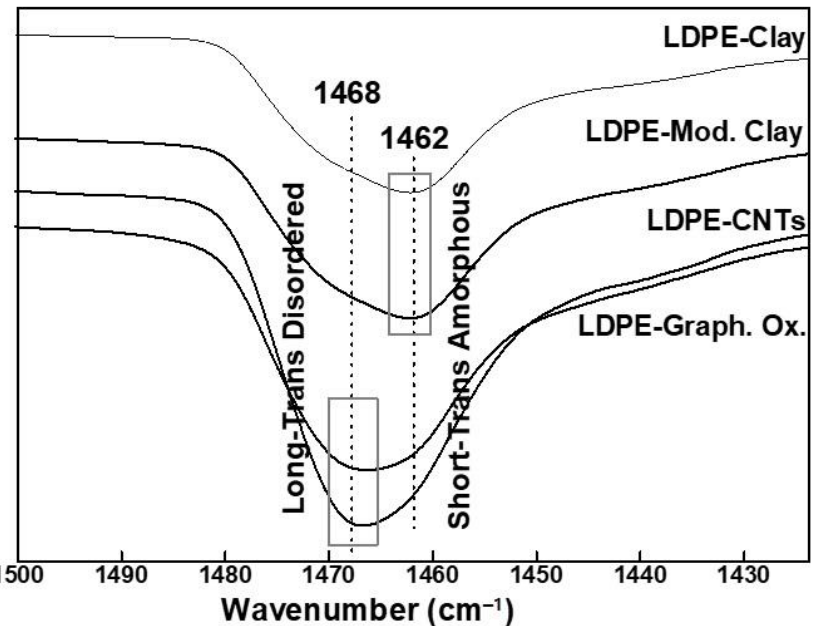
Figure 9. FTIR spectrum of LDPE-based nanohybrids in spectral region of 1500 – 1420 cm −1 .